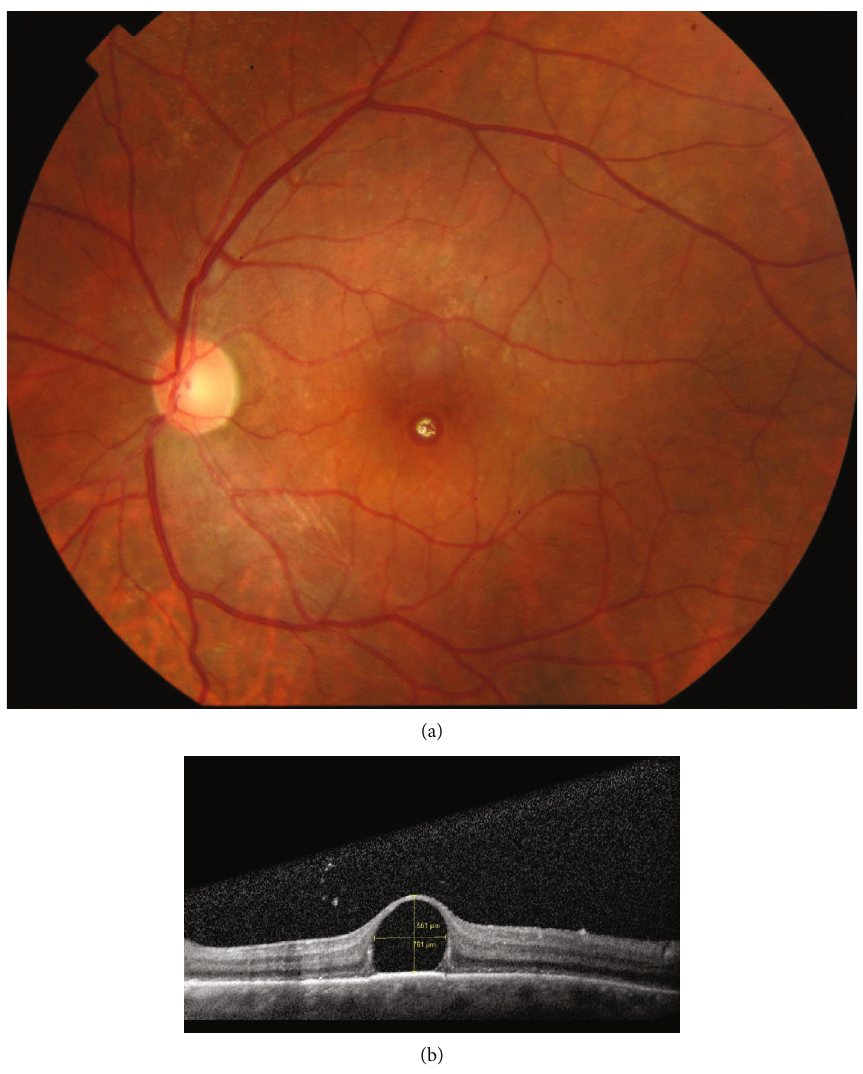
Figure 1: (a) Colored fundus photography showing subfoveal PFCL droplet. (b) OCT showing Ώ